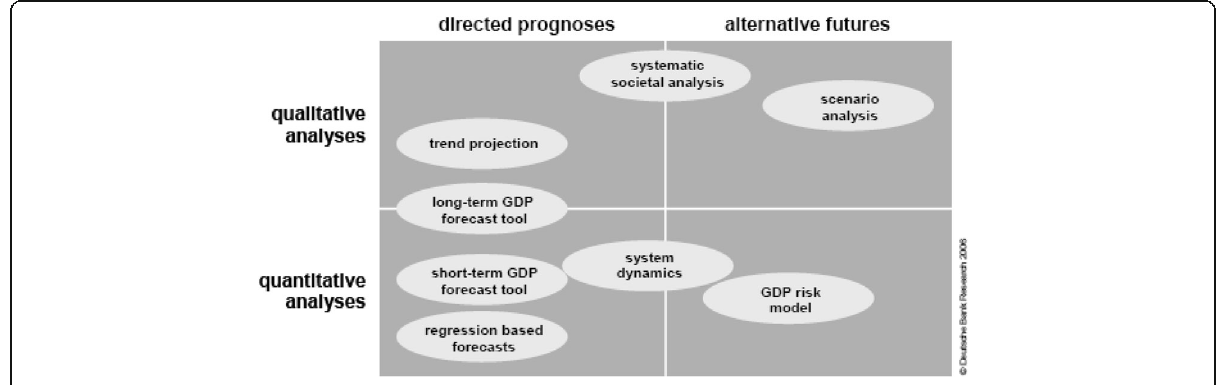
Fig. 1 Deutsche Bank Research ’ s classification